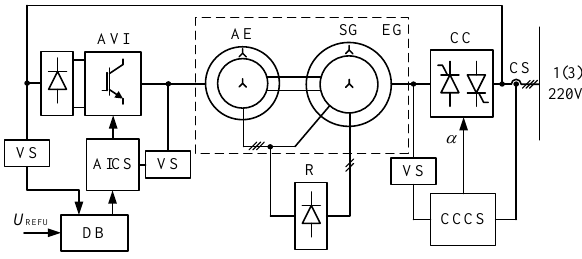
Figure 2. Functional diagram of stabilizing system of the electrical output voltage parameters by means of AC excitation winding circuit